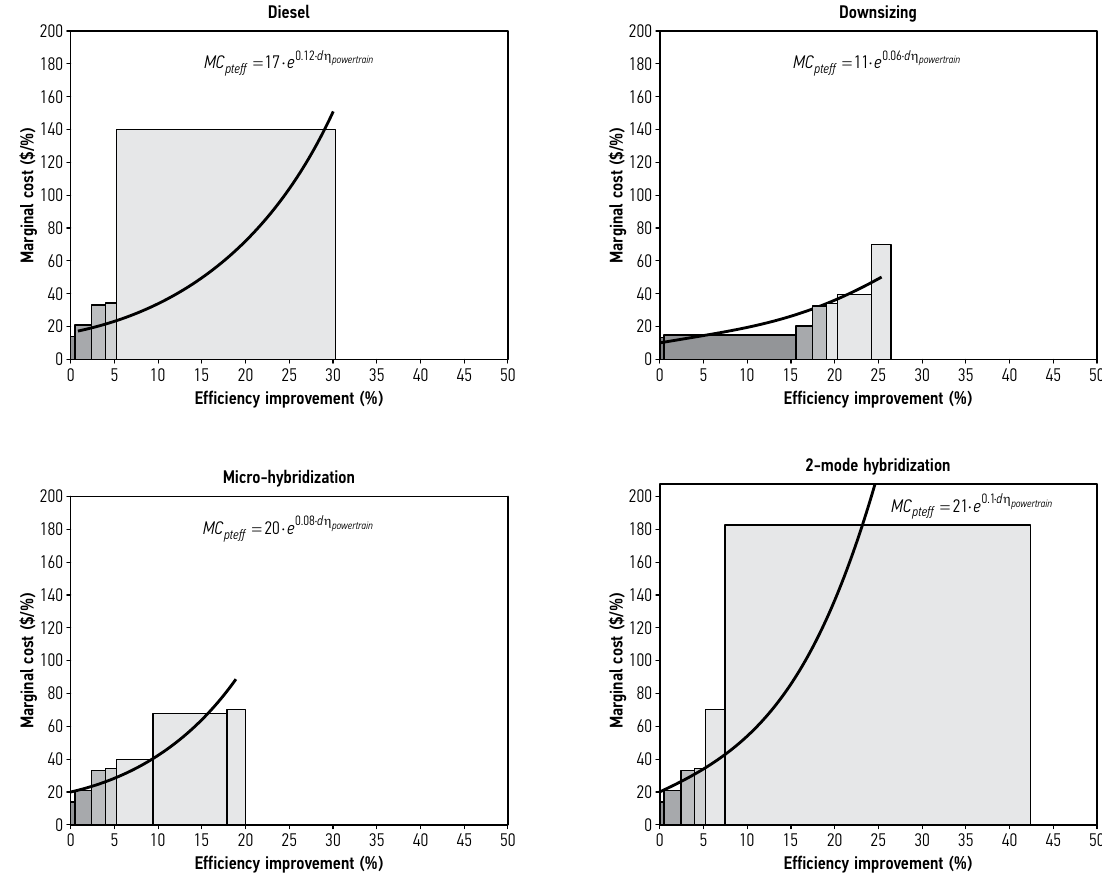
Fig. 8. Four efficiency technology implementation scenarios are used to develop marginal cost of implementation functions assuming that the lowest marginal cost will be implemented first